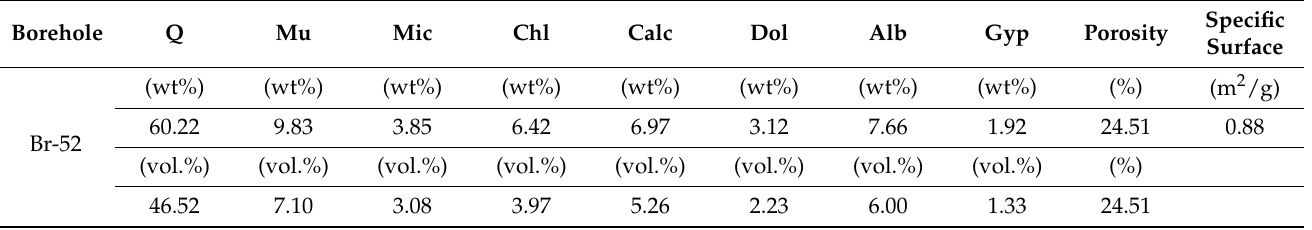
Table 3. Mineralogical composition of the studied rock sample (wt%) and conversion to percentages by volume (vol.%).